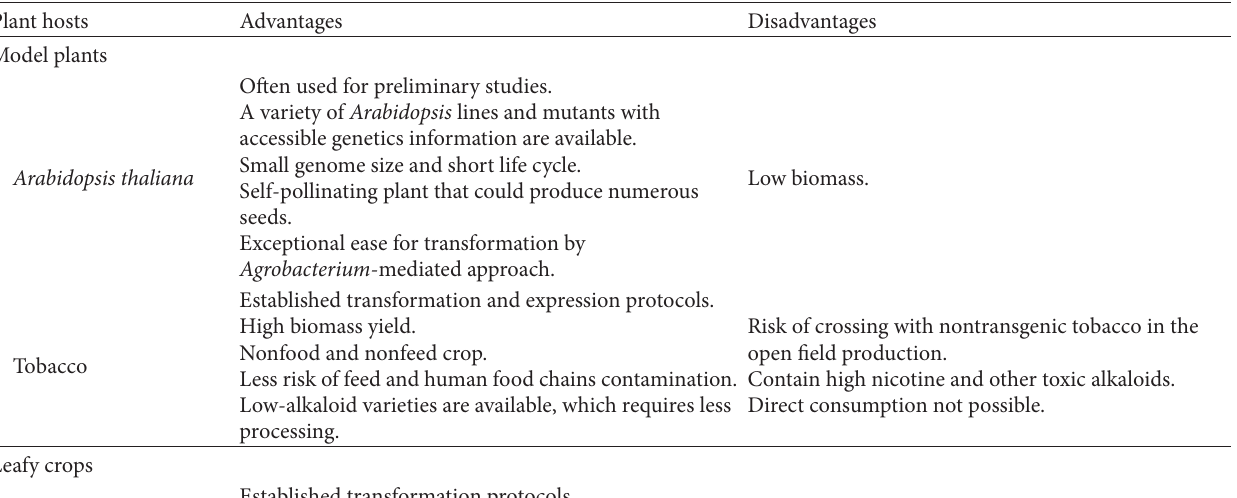
Table 2: Comparison of different plant-based expression platforms for recombinant proteins